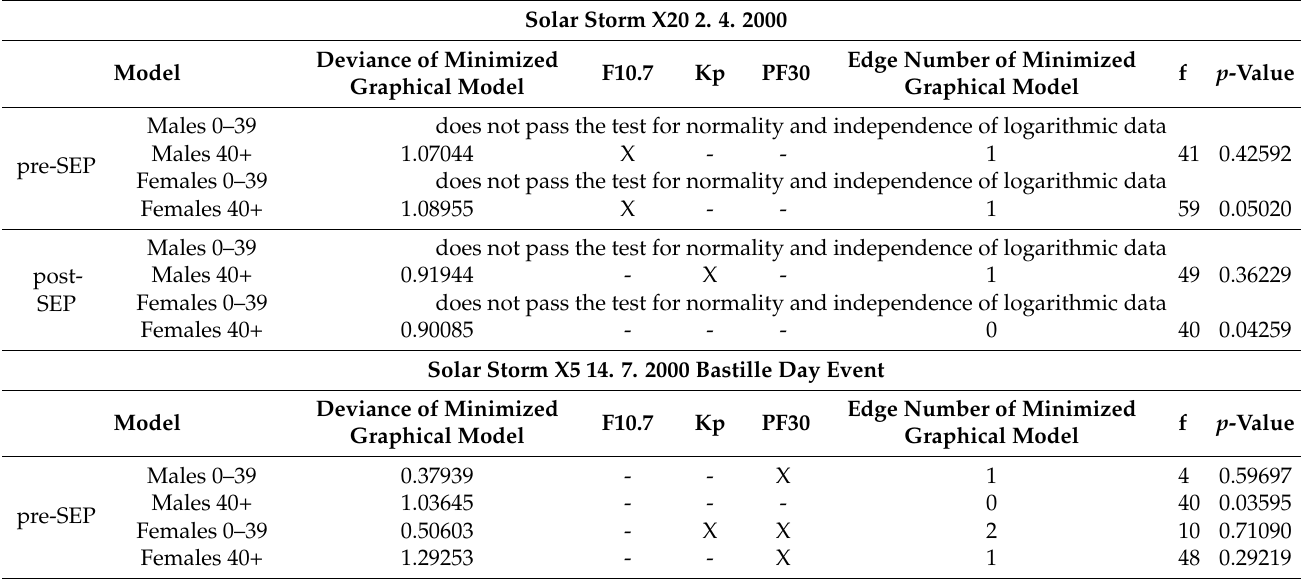
Table 2. Summary of conditional independence graphs (CIG) model computation. Diseases of the nervous system